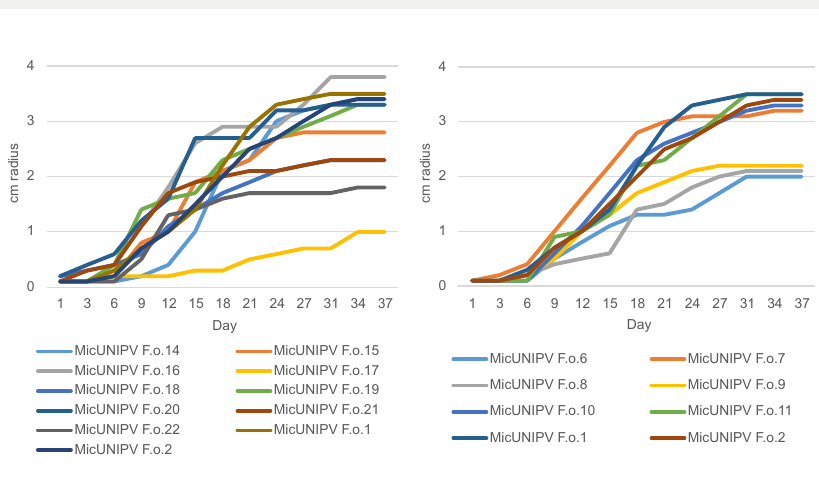
Figure 11 Growth curves of strains from Alpe Veglia (le) and Alpe Devero (right) on cellobiose